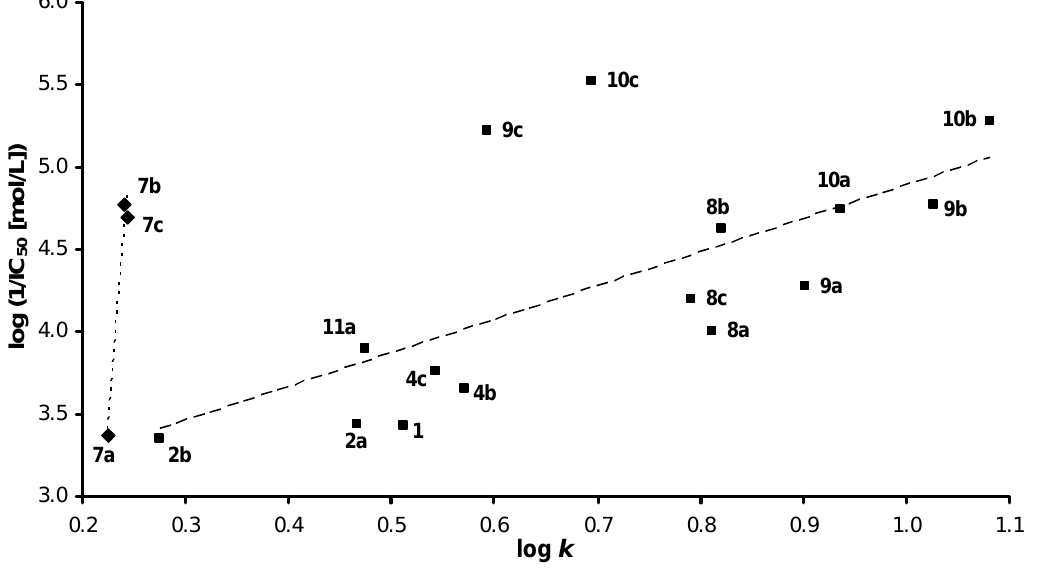
Figure 1. Dependence of log (1/IC chloroplasts on the compound lipophilicity expressed by log k